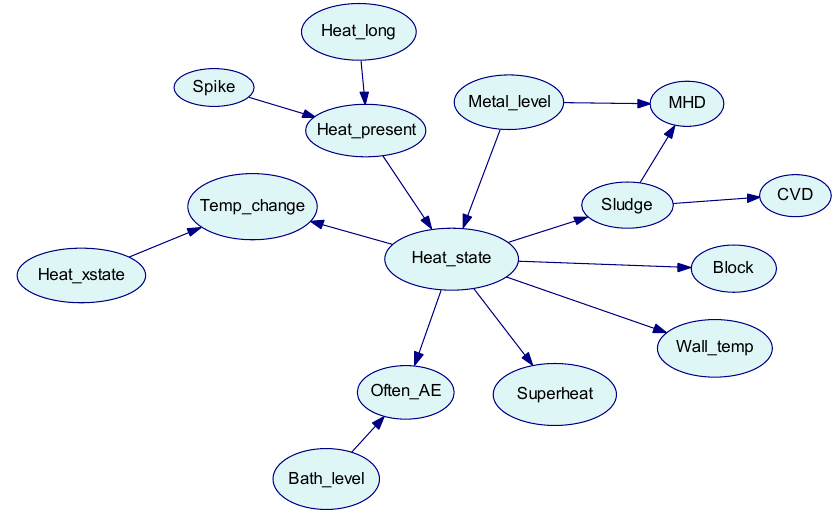
Figure 1. Bayesian network for diagnosis of “Heat_state”.